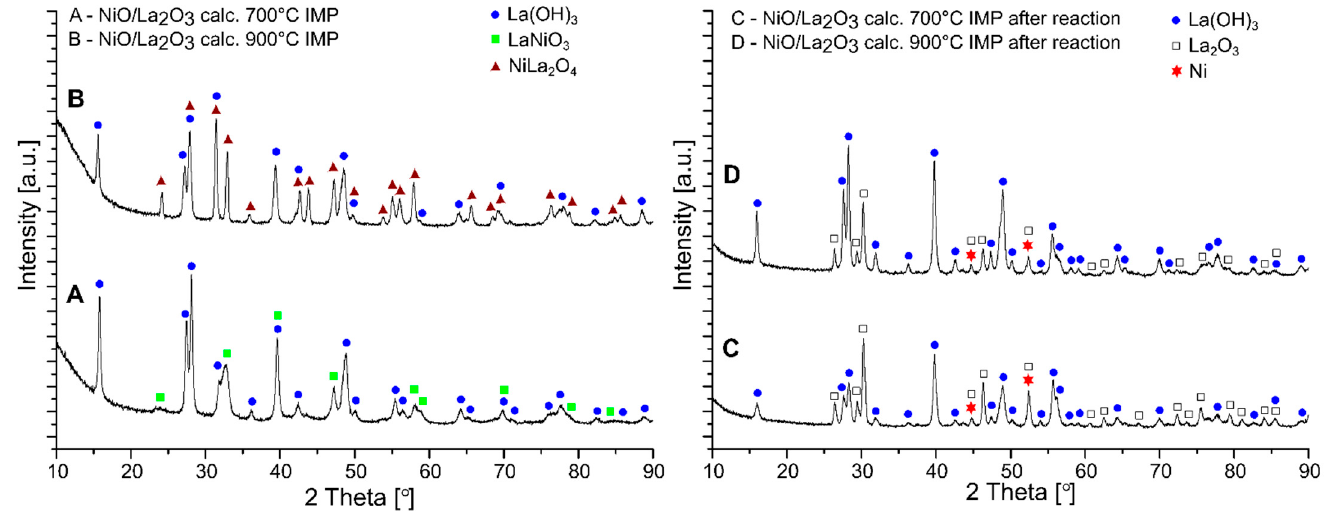
Figure 5. XRD diffraction patterns recorded for the NiO/La 2 O 3 catalysts prepared by wet impregnation method and calcined in an air atmosphere for 4 h at 700 and 900 ◦ C and for spent systems.